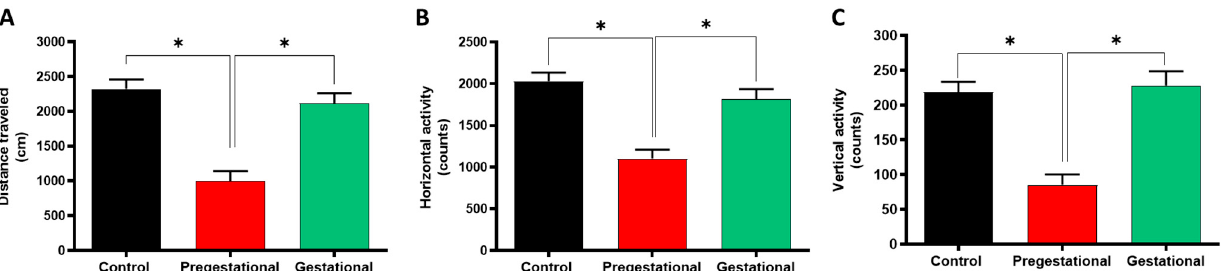
Figure 1. Effect of maternal immunization with T. gondii lysate on the ( A ) distance traveled, ( B ) horizontal activity and ( C ) vertical activity of the progeny. The locomotor activity was evaluated at PND 60 of the progeny of mothers that received PBS (control), the progeny of mothers immunized previously to gestation (Pregestational) and the progeny of mothers injected with T. gondii lysate at gestational day 18 (Gestational). Data are the mean ± SEM (n = 12–15 per group). * p < 0.01, based on the Kruskal–Wallis test with Dunn’s test for multiple pairwise comparisons.